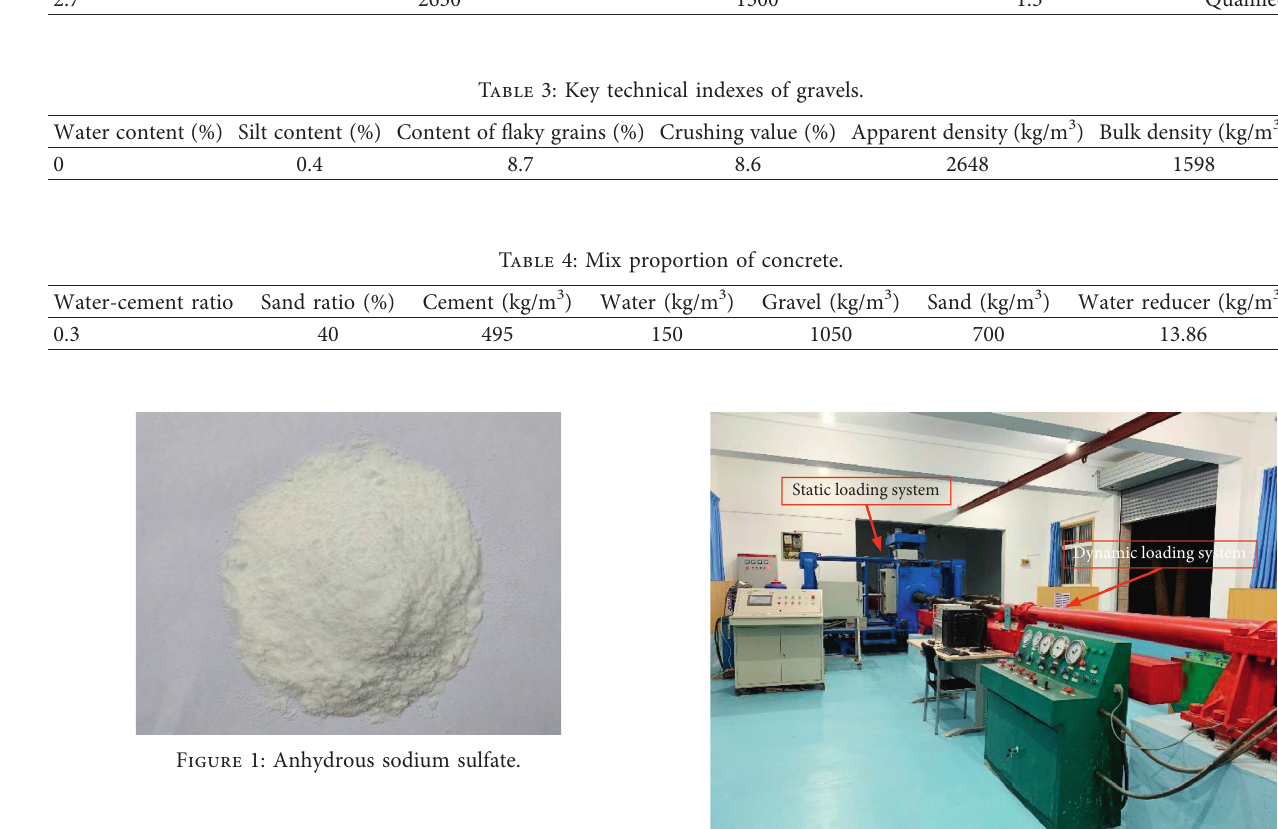
Figure 3: Integrated true triaxial static and dynamic loading test